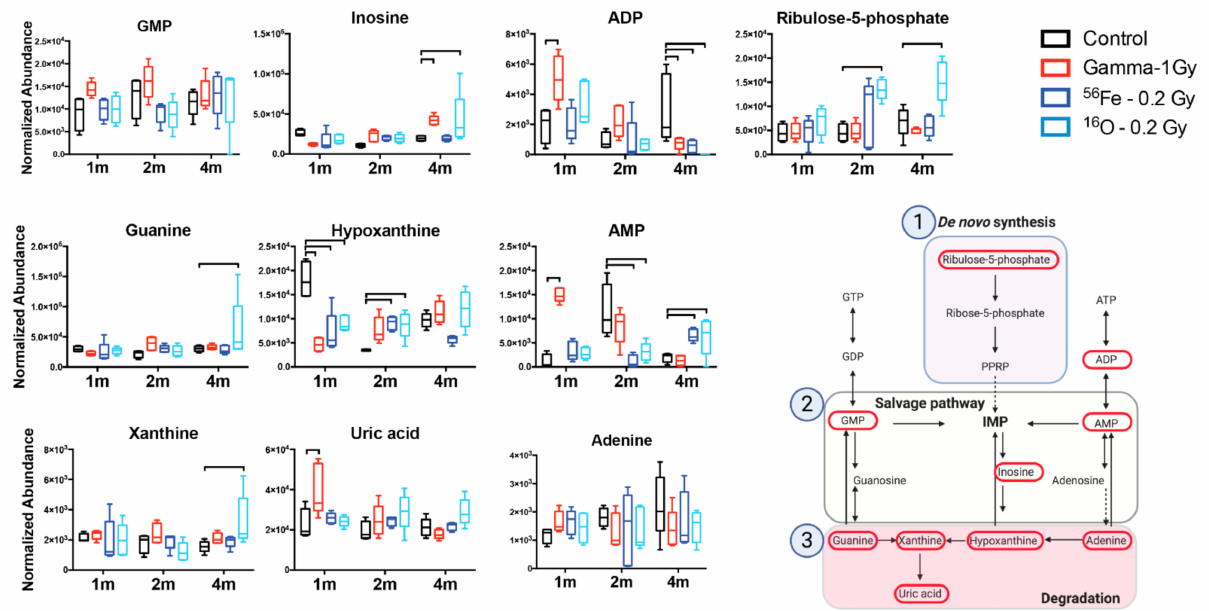
Figure 4. Specific changes in the purine metabolism highlight involvement of the whole pathway. Metabolic levels over 3 time points show the early responses to all exposure types, while the 4m time point shows persistent responses in the catabolic pathway specific to oxygen HZE irradiations. Brackets correspond to a p < 0.05 of an exposed group compared to control within that time point. Figure of the purine metabolism pathway was created with BioRender.com (accessed on 25 January 2021).